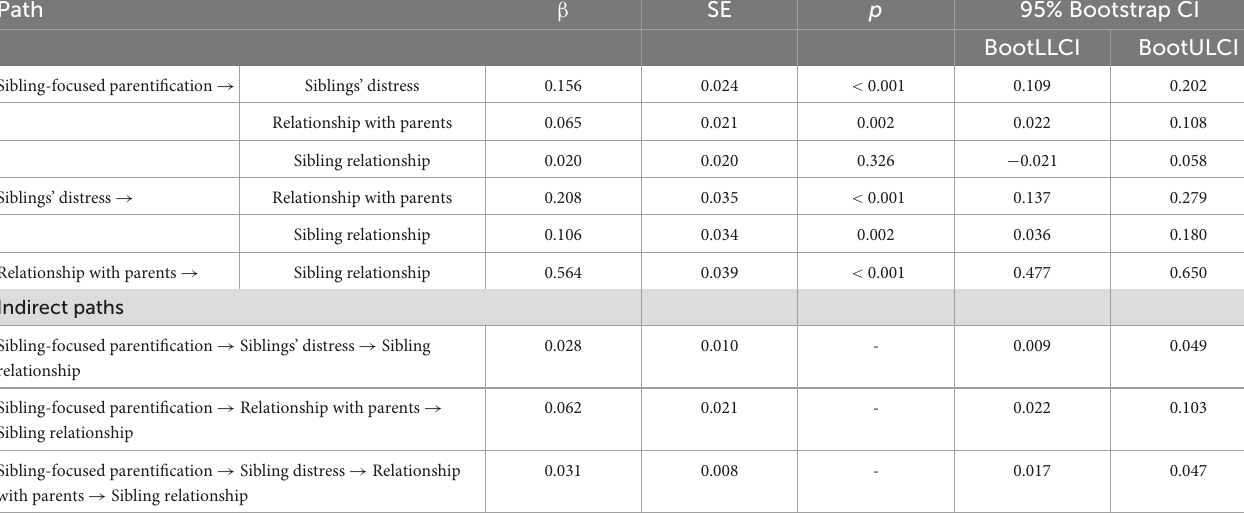
TABLE 3 Betas coefficients, standard errors, p -values, and bootstrap confidence intervals of serial mediation